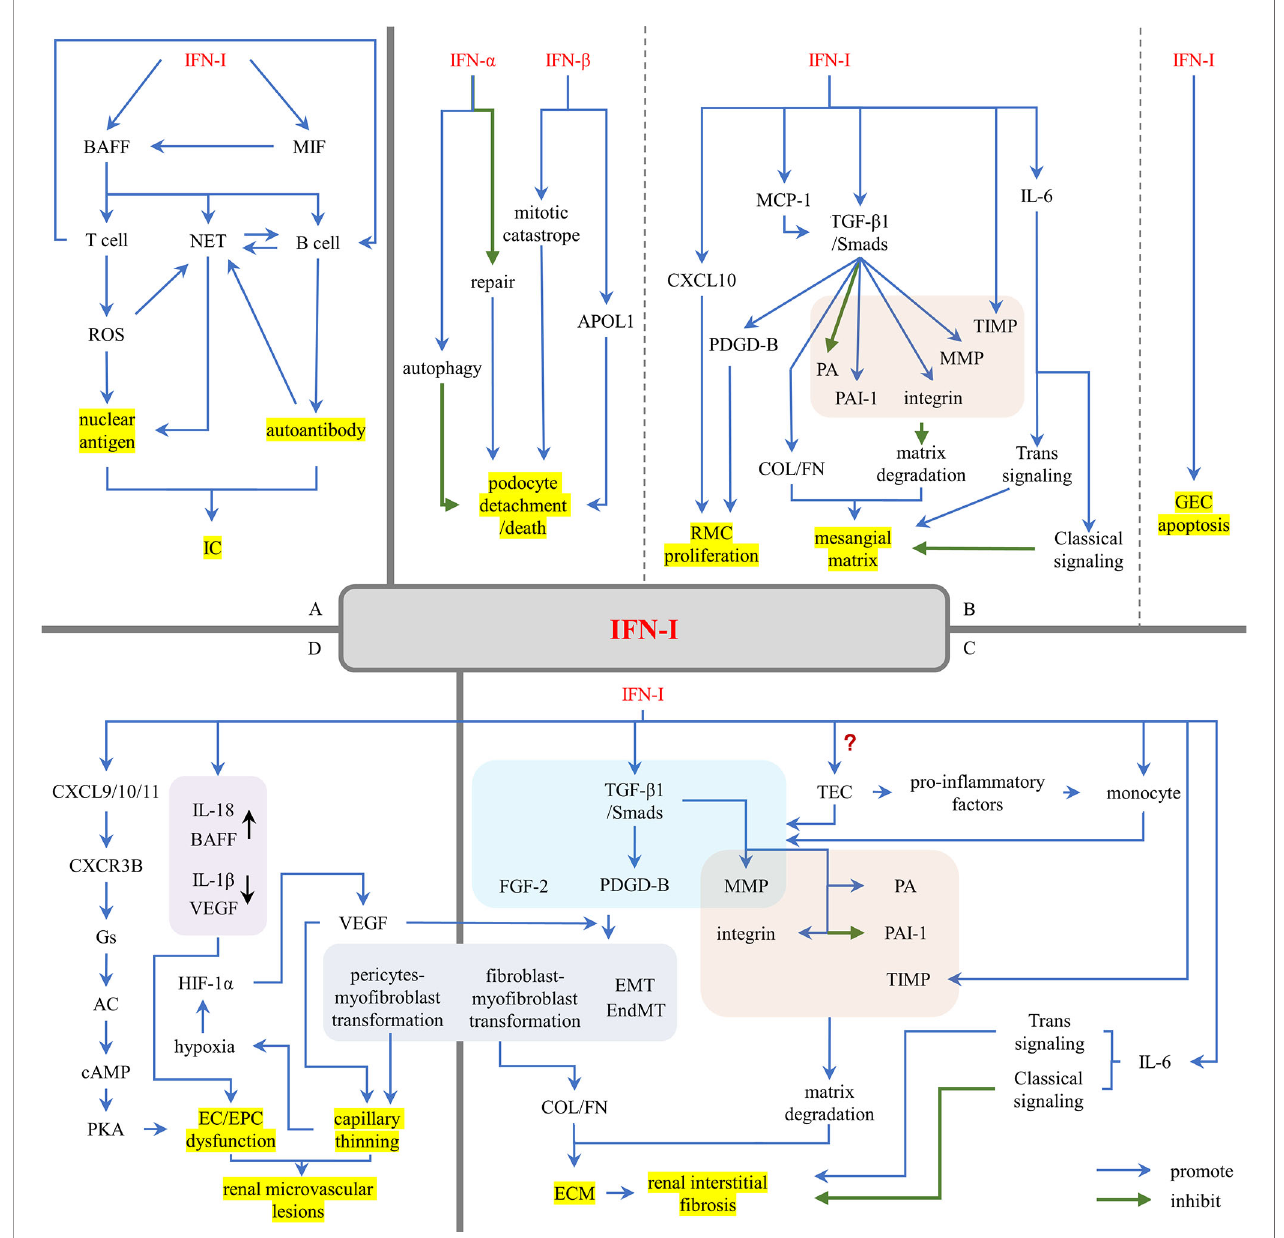
FIGURE 4 | The damage effects of IFN-I in LN. (A) IFN-I promotes the formation of nuclear antigens and autoantibodies. (B) IFN-I promotes glomerular sclerosis. (C) IFN-I promotes renal interstitial fi brosis. (D) IFN-I promotes renal microvascular lesions. AC, adenylyl cyclase; APOL1, apolipoprotein L1; BAFF, B cell activating factor; cAMP, cyclic adenosine monophosphate; COL, collagen; CXCL, (C-X-C motif) ligand; CXCR3B, chemokine-receptor-3B; EC, endothelial cell; ECM, extracellular matrix; EMT, epithelial-to-mesenchymal transition; EndMT, endothelial-to-mesenchymal transition; EPC, endothelial progenitor cell; FGF-2, fi broblast growth factor 2; FN, fi bronectin; GEC, glomerular endothelial cell; HIF-1 a , hypoxia-inducing factor-1 a ; IC, immune complex; IFN-I, type I interferons; MCP-1, monocyte chemotaxis proteins 1; MIF, macrophage inhibitory factor; MMP, matrix metalloproteinases; NET, neutrophil extracellular trap; PA, plasminogen activator; PAI-1, plasminogen activator inhibitor 1; PDGD, PDGF, platelet-derived growth factor; PKA, protein kinase A; RMC, renal mesangial cell; ROS, reactive oxygen species; TEC, renal tubular epithelial cell; TIMP, tissue inhibitors of metalloproteinases; TGF- b 1, transforming growth factor- b